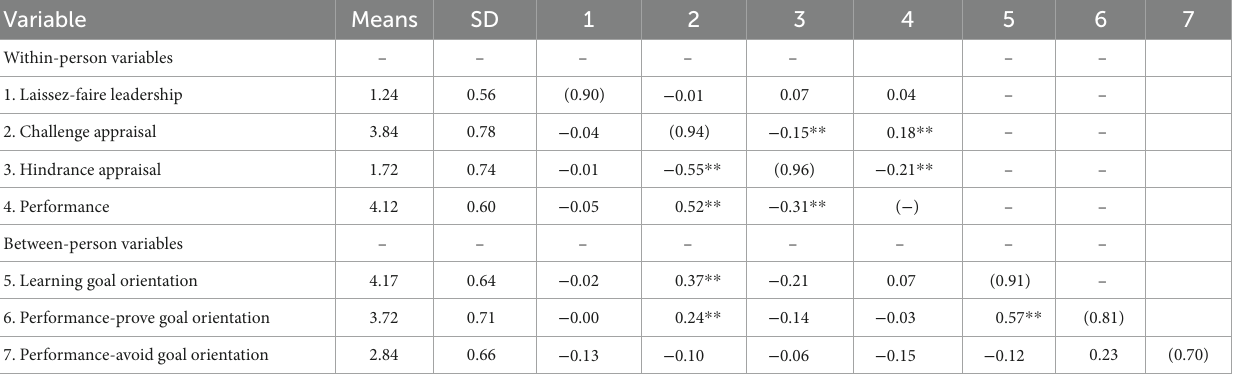
TABLE 1 Descriptive statistics, correlations, and